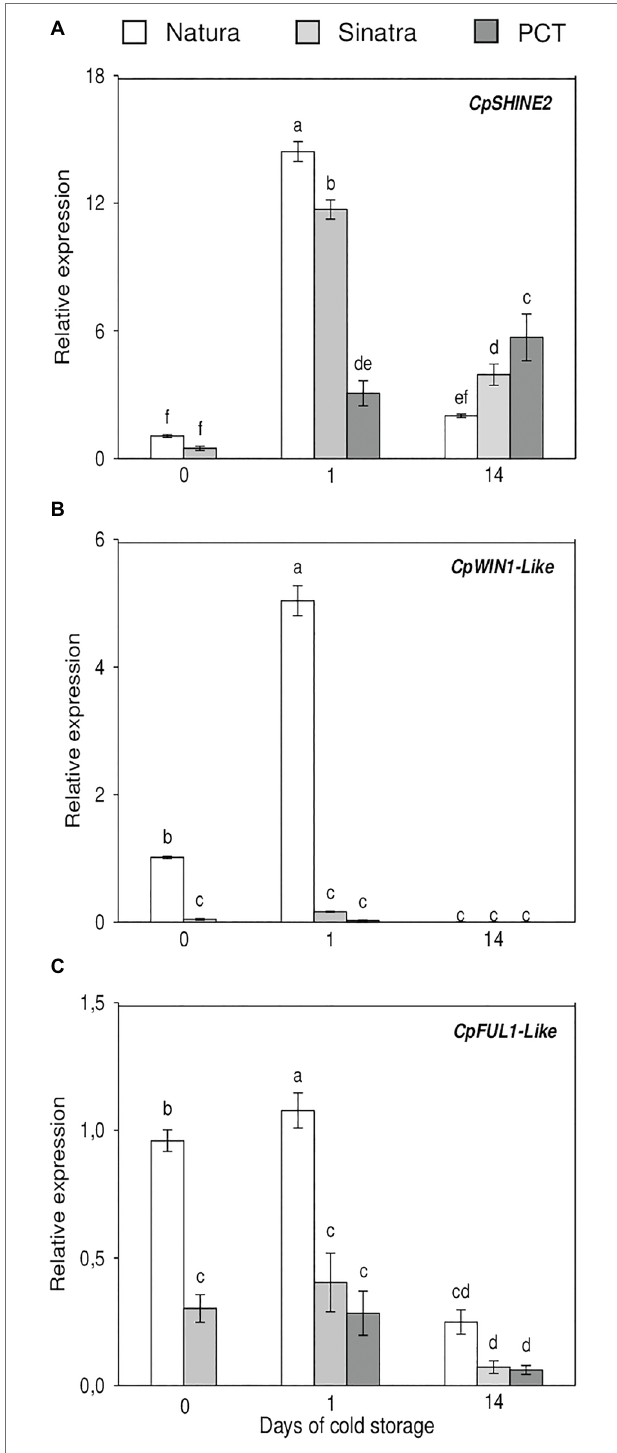
FIGURE 5 | Relative expression of the transcription factors CpSHINE2 (A) , CpWIN1-like (B) , and CpFUL1-like (C) in the exocarp of ‘Natura’ and ‘Sinatra’, including PCT ‘Sinatra’ fruit, at harvest and after 1 and 14 days of storage at 4 ° C. Data presented are means ± SE of triplicate samples of six fruits each. Different letters indicate significant differences according to Duncan’s test ( p <